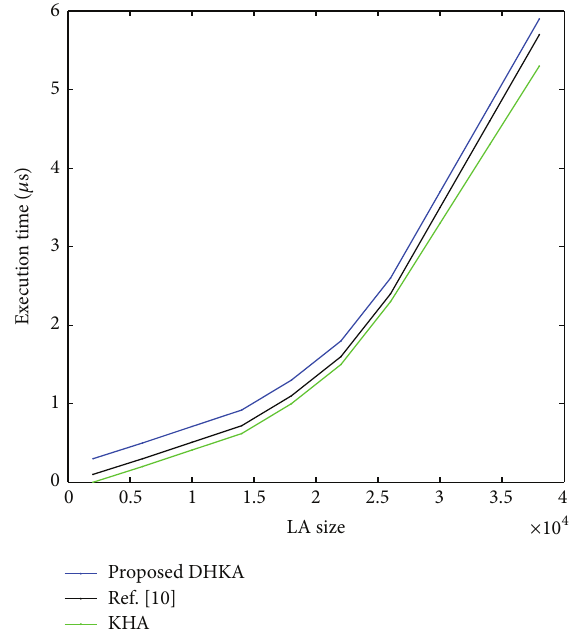
Figure 8: Simulation time of the proposed techniques with respect to LA size (Dummy).